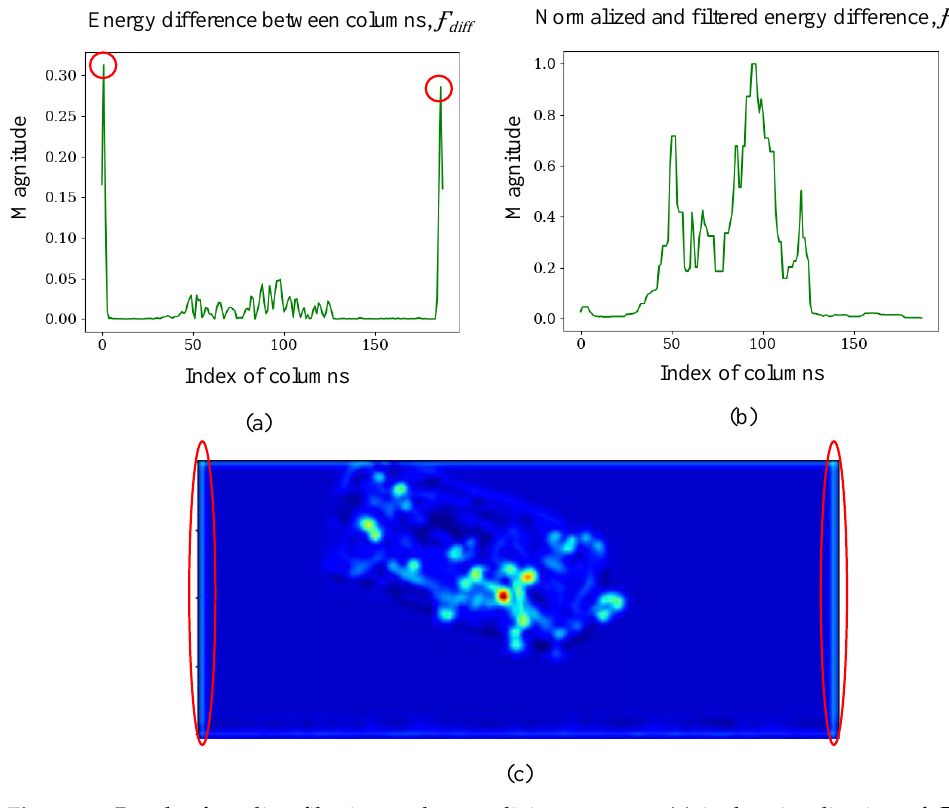
Figure 7. Result of median filtering and normalizing process. ( a ) is the visualization of F dif f , the energy difference between columns of feature map. ( b ) is the visualization of F norm , the result of normalization and filtering process of F dif f . ( c ) is the feature map, and the spikes labeled by the red circles caused by X-ray artifacts in F dif f can be seen in ( a , c ), which are removed by the median filter. Threshold-based cropping. We determine a threshold k based on F norm to efficiently crop the image without removing salient objects. If F ni > k , the rate of change of column i is higher than the threshold, and column i indicates the start of regions of interest. F norm is scanned from left to right and vice versa to determine the horizontal boundary of the cropping region. We repeat the process vertically to decide the vertical boundary for the region of interest (RoI). After that, the original image will be cropped according to the RoI on the feature